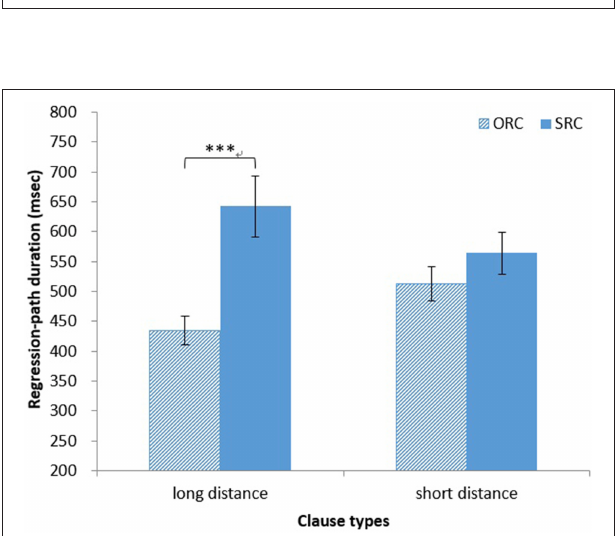
FIGURE 5 | Japanese group: gaze duration for HNs in RCs. * p < 0.05 , ** p < 0.01 .